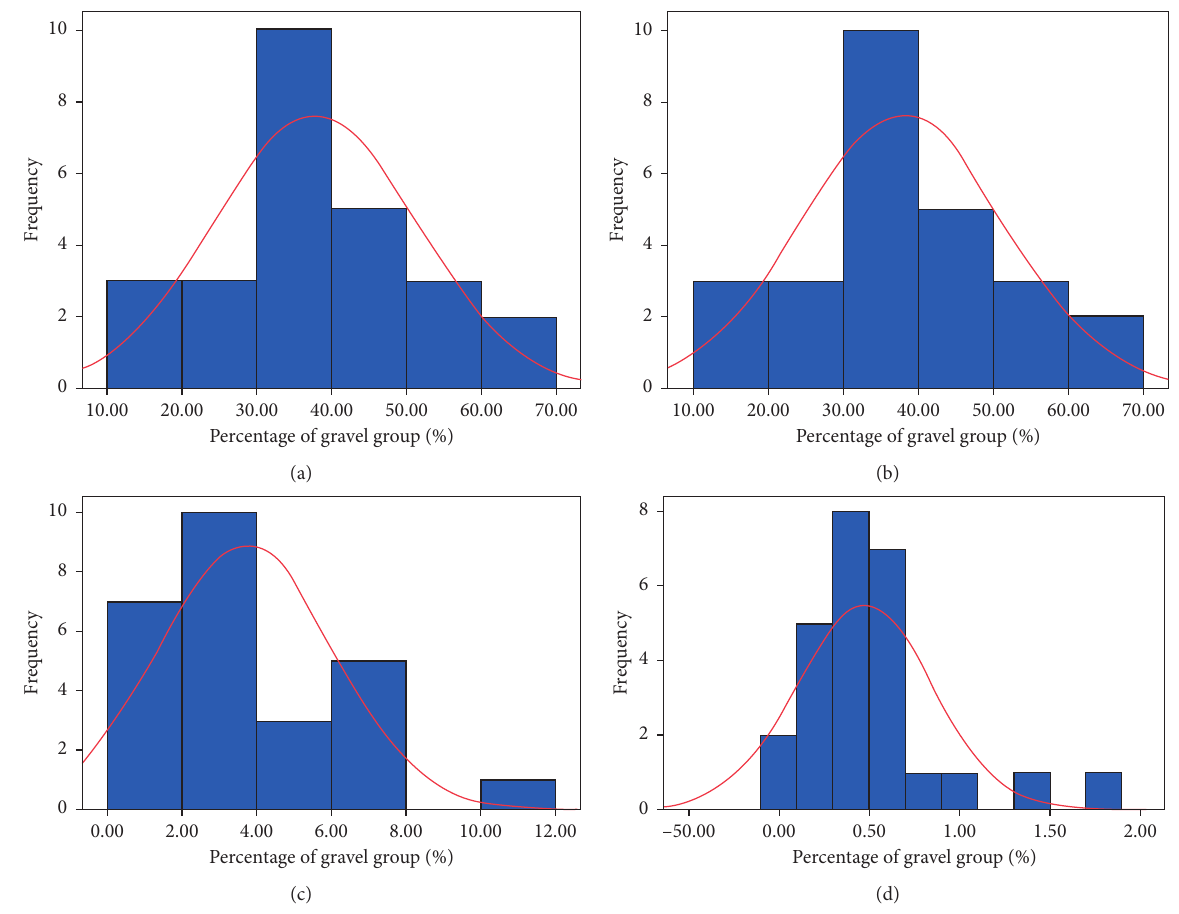
Figure 6: Frequency distributions for different categories of debris flow particle sizes. (a) Gravel. (b) Sand. (c) Powder. (d)